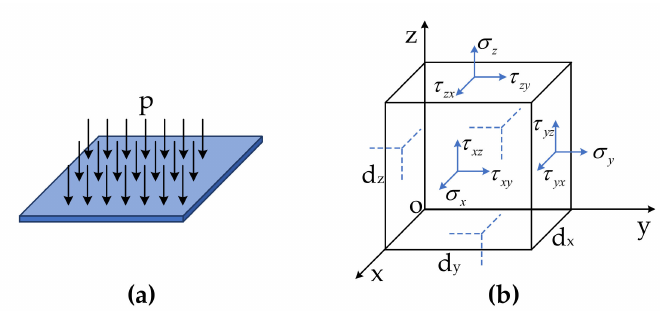
Figure 4. Theoretical modeling of cuboid hydrophone sensor head. ( a ) Pressure model; ( b ) stress distribution of hexahedral element in Cartesian